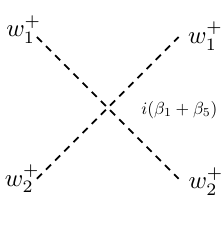
Figure 1 . Quartic coupling for w +